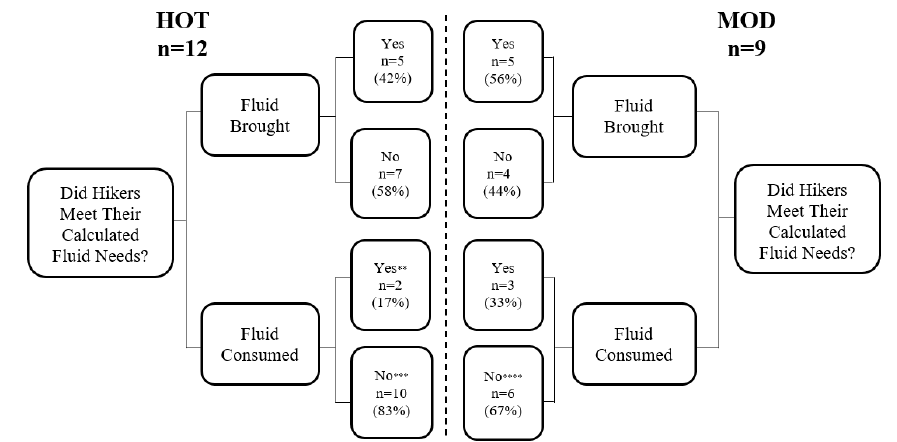
Figure 3. Categorization of hikers’ fluid behavior in HOT and MOD. ** One hiker met fluid needs by using “rescue water” (RW); *** Five hikers used RW and still did not meet their needs; **** One hiker used RW and still did not meet personal fluid needs.